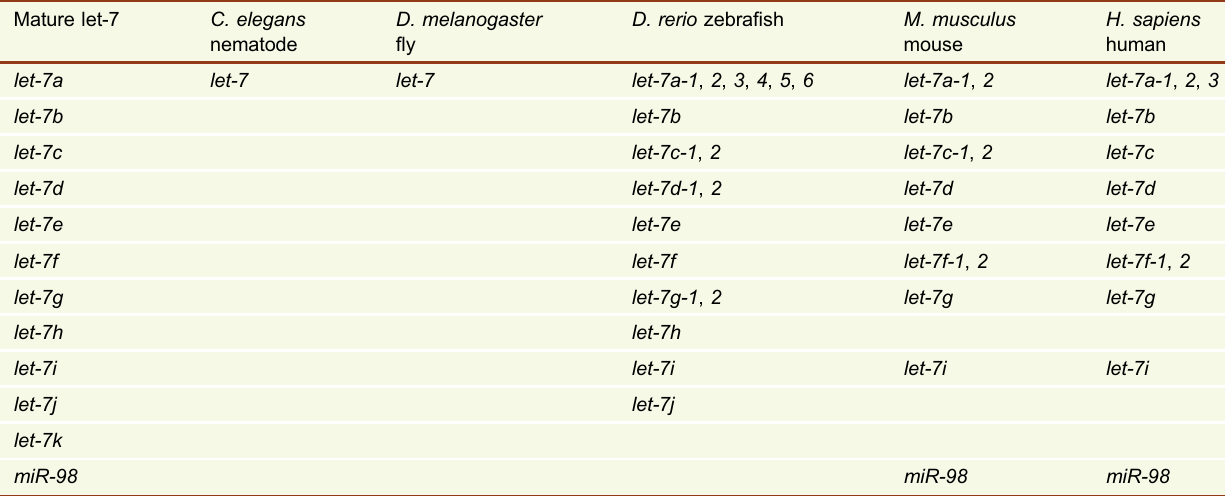
Table 1. Characterization of let-7 family across different species Mature